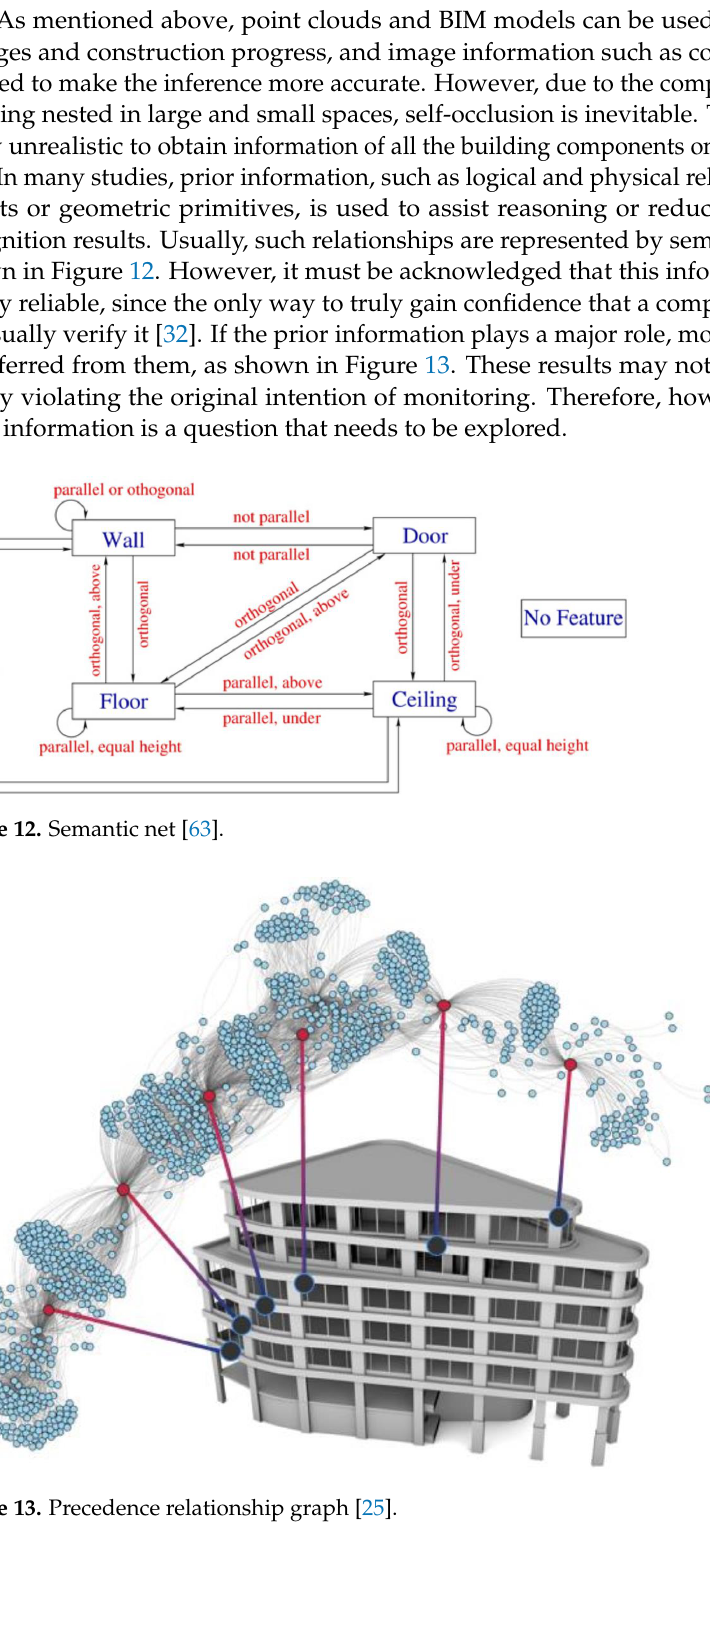
Figure 13. Precedence relationship graph [25].